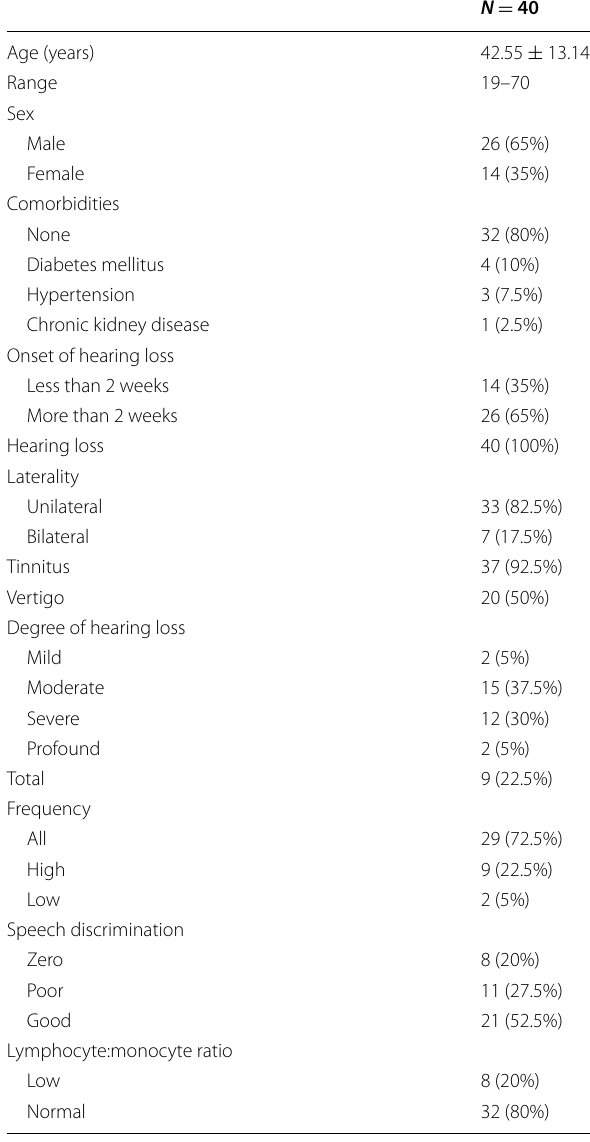
Table 1 Baseline data of studied patients